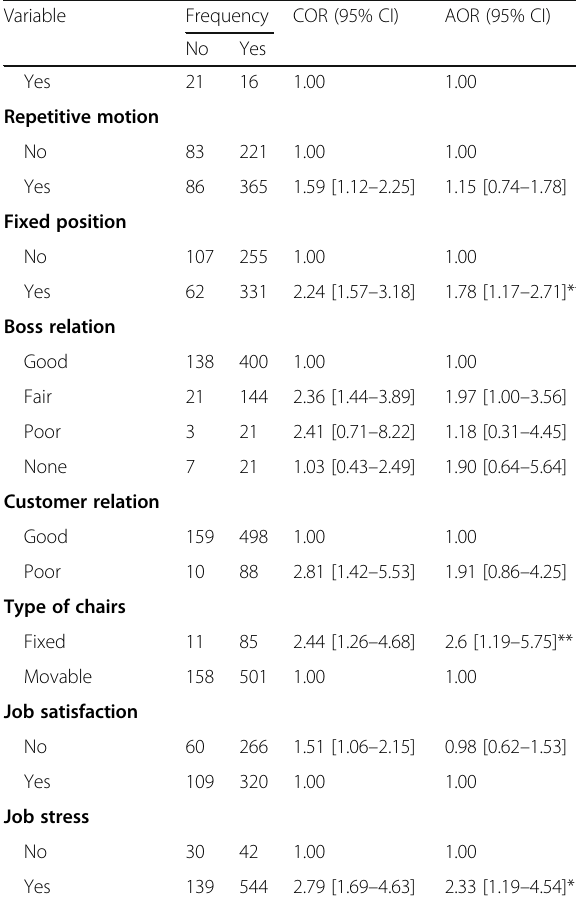
Table 4 Multi variable analysis of factors associated with work- related musculoskeletal disorders among bank workers, Addis Ababa, Ethiopia, 2018 ( N = 755)